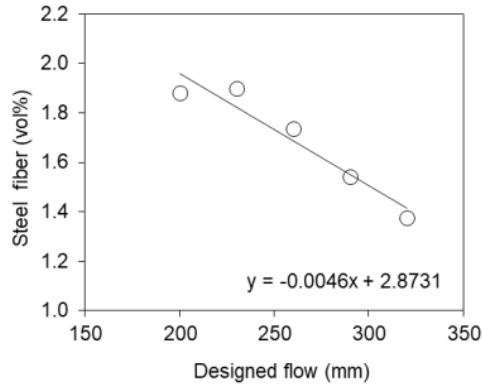
Figure 28. UHPFRC flow—steel-fibre volume.